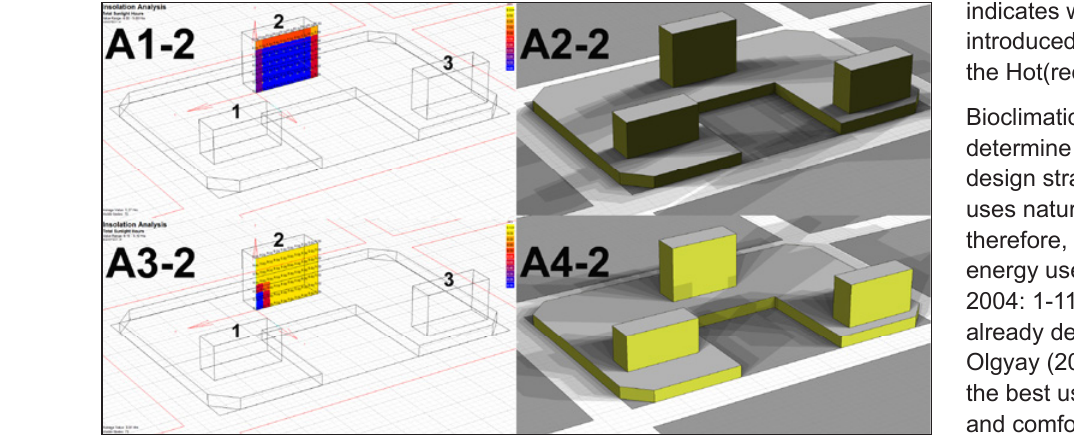
Figure 13: Solar insolation and overshadowing simulations for building orientation A using a Form Based Approach.